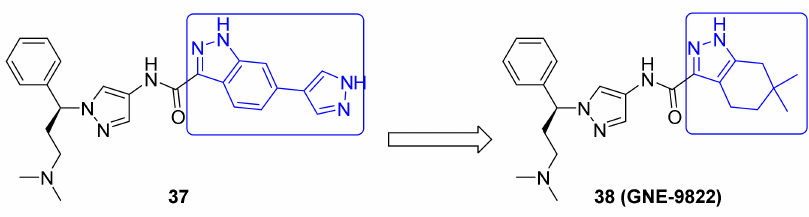
Figure 39. Structures of pyrazole-based ITK inhibitors and their Ki values.